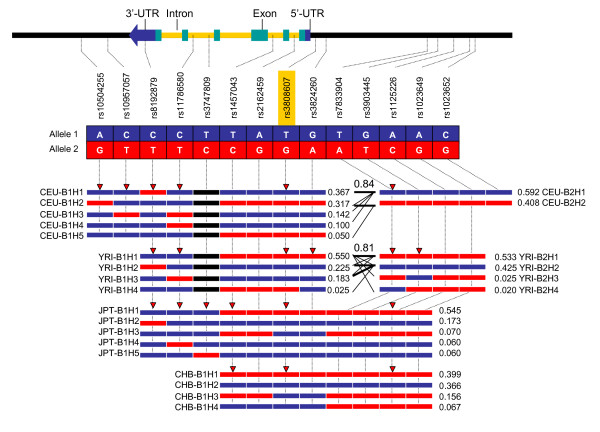
Haplotype frequencies of the HapMap selected SNPs in the CYP7A1 gene in CEU, YRI, JPT, and CHB. In each haplotype, blue bars represent allele 1, whereas red bars represent allele 2 for correlated SNPs. Black bars indicate that the SNPs are not present in this population. Numbers next to each haplotype bar are haplotype frequencies. Up-side-down red triangles indicate htSNPs in the populations. In the crossing areas, a value of multiallelic D' is shown to represent the level of recombination between the two blocks.